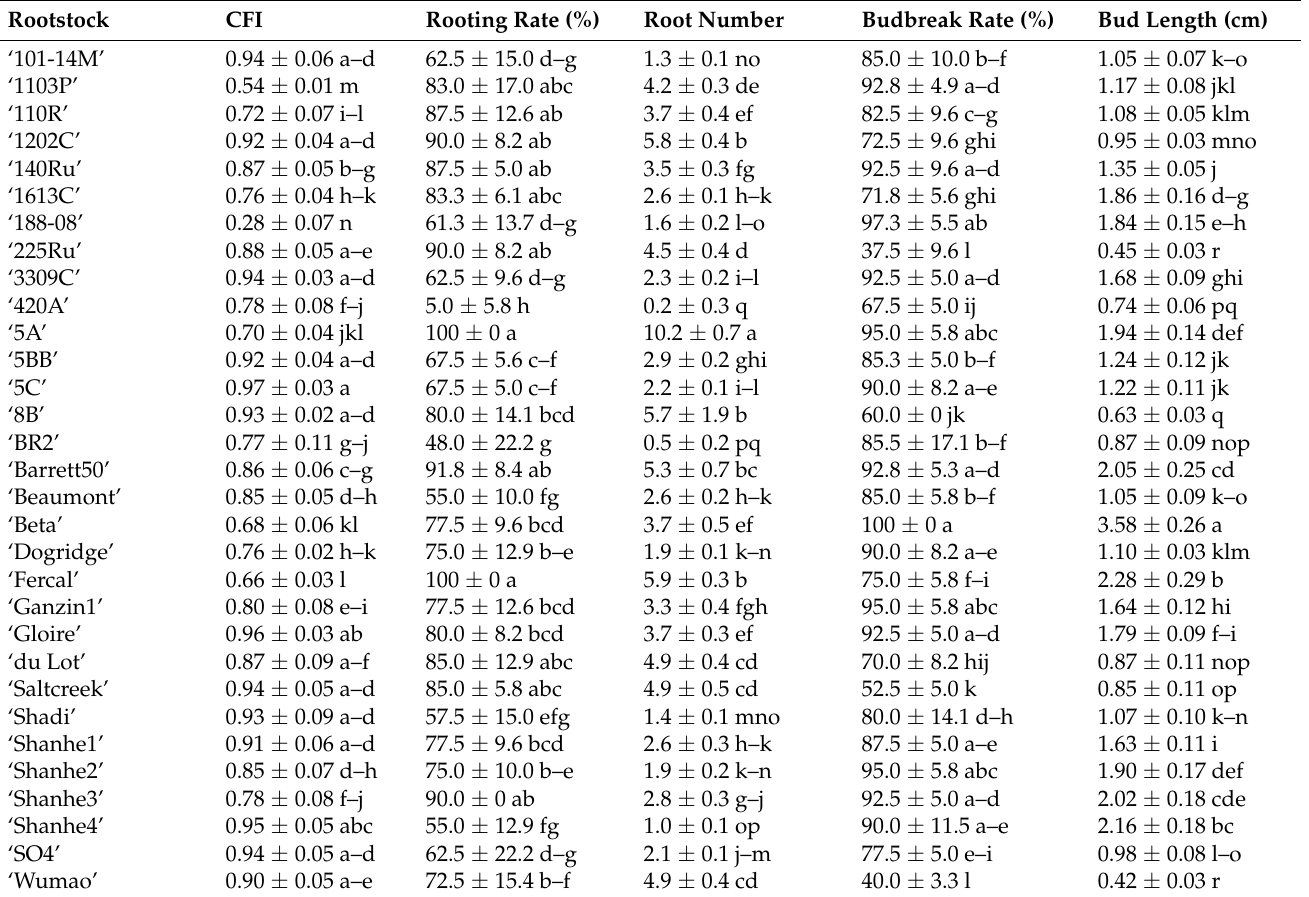
(Figure S2). Averagely, the lignified shoot length and total shoot length of ‘110R’ were the largest, more than twice those of ‘Gloire’, ‘1613C’, or ‘Shadi’. The variation in lignification rates was relatively small, with a range of 73–100%. Shoots of ‘Gloire’, ‘Beaumont’, and ‘3309C’ were less lignified, lower than 75%. The internode lengths ranged from 3.2 to 7.8 cm, being higher on varieties with longer shoots and lower on those with shorter shoots. Table 2. Multiplication traits of the grapevine rootstock cuttings after being nursed for 40 days.